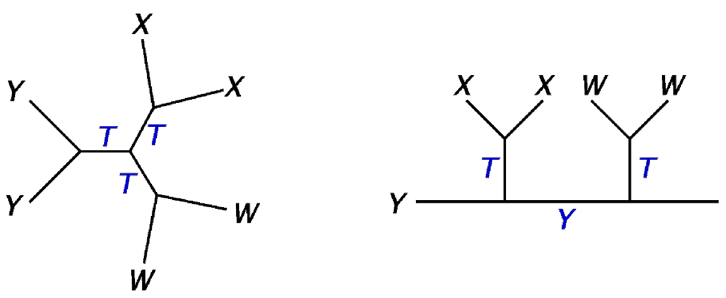
Figure 1 . Illustration of the two di(cid:11)erent OPE channel topologies relevant for universal contribu- tions to the six-point block of pairs of operators X; Y; W . The left (cid:12)gure shows the star channel identity block, which involves purely stress tensor exchanges. For comparison, on the right hand side we also show the comb channel , which involves an intermediate exchange that is identical to one of the external probe